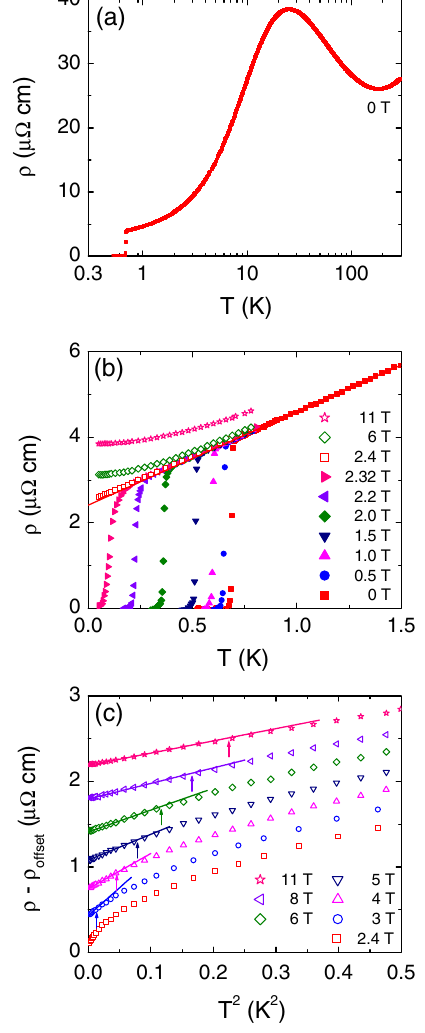
FIG. 1. (a) In-plane resistivity of the Ce 2 PdIn 8 single crystal in zero field. The curve is very smooth below 20 K, showing no impurity phases in the sample. (b) Low-temperature resistivity of PdIn c axis. The solid Ce 2 8 in magnetic fields applied along the line is a linear fit of the zero-field data between 0.7 and 1.5 K. (c) (cid:1) vs T 2 for H ¼ 2 : 4 , 3, 4, 5, 6, 8, and 11 T . (Data sets are offset for clarity.) The solid lines are fits to (cid:1) ¼ (cid:1) 0 þ AT 2 . The arrows indicate the upper limit of the temperature range of T 2 behavior.